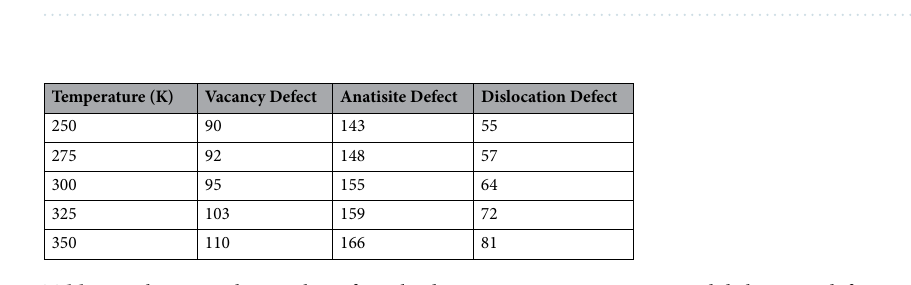
Table 5. BAG’s mechanical/atomic properties in terms of initial temperature in the MD box.